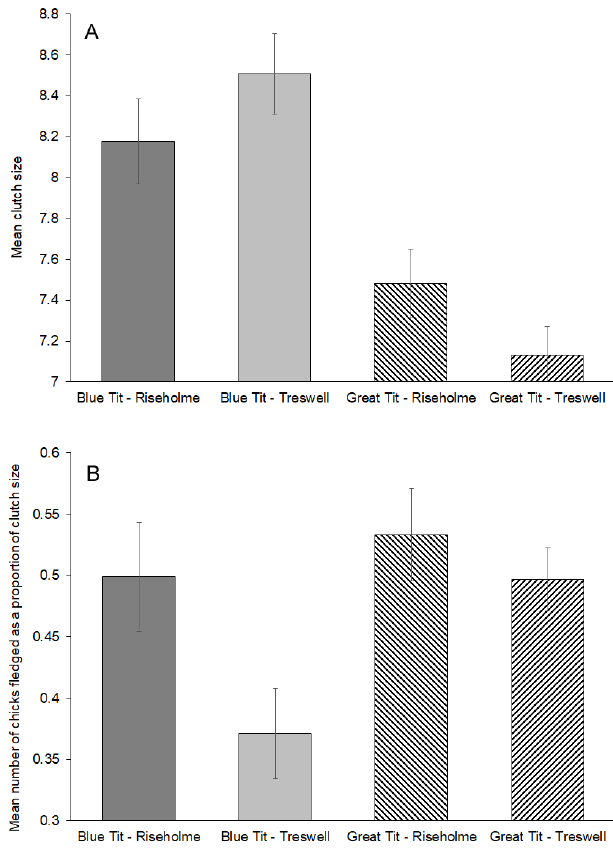
Fig. 4 . Mean (± SE) for (A) mean clutch size and (B) the proportion of the clutch size that fledged for Blue Tits ( Cyanistes caeruleus ) and Great Tits ( Parus major ) from Riseholme Park and Treswell